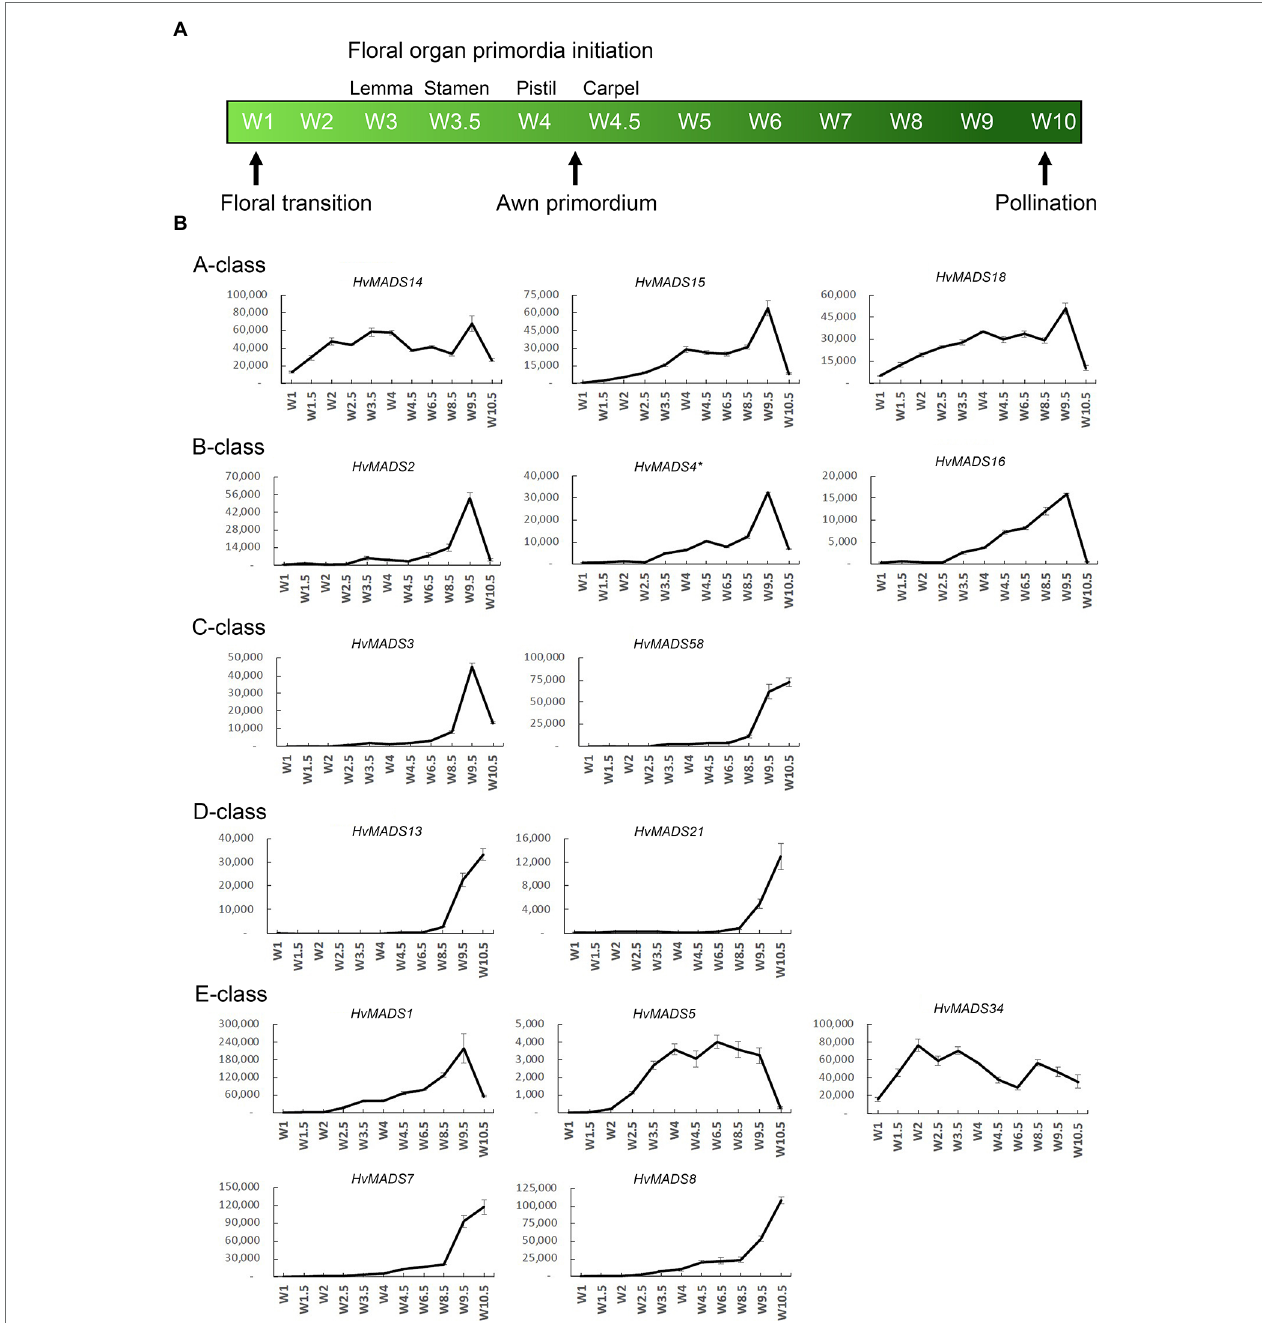
FIGURE 3 | (A) Waddington stages for barley and their relation to major developmental steps. (B) Transcript profiles of AP1, AP3/PI, AG(C), AG(D) and SEP MIKCc MADS-box genes in the shoot apex through inflorescence development as measured by the Waddington stage in Golden Promise. Error bars represent one standard deviation, based on technical replicates. A-class: The predicted A-class function in the outer floral organs predicts that transcript starts after W3, where the lemma primordium is first formed. However, expression of all three AP1 genes increases earlier, at the floral transition W1. AP3/PI: The expression of predicted B-class genes starts to increase at W3.5, where the stamen primordia are formed, and peaks right before pollination. AG(C): HvMADS3 and HvMADS58 both start expression around W3.5 when the stamen primordia appear, however HvMADS3 peaks before pollination and declines quickly afterwards, while HvMADS58 maintains peak expression through to W10. AG(D): HvMADS13 and HvMADS21 both start significant expression only after W6.5, well after the pistil primordium is formed, which first appears at W4. Their peak expression is after pollination. E-class: There is a clear difference between the LOFSEP genes HvMADS1 , HvMADS5 and HvMADS34 that express earlier and sharply drop at pollination (W10) and HvMADS7 and HvMADS8 expression, which starts later around W3.5 and continues to rise through